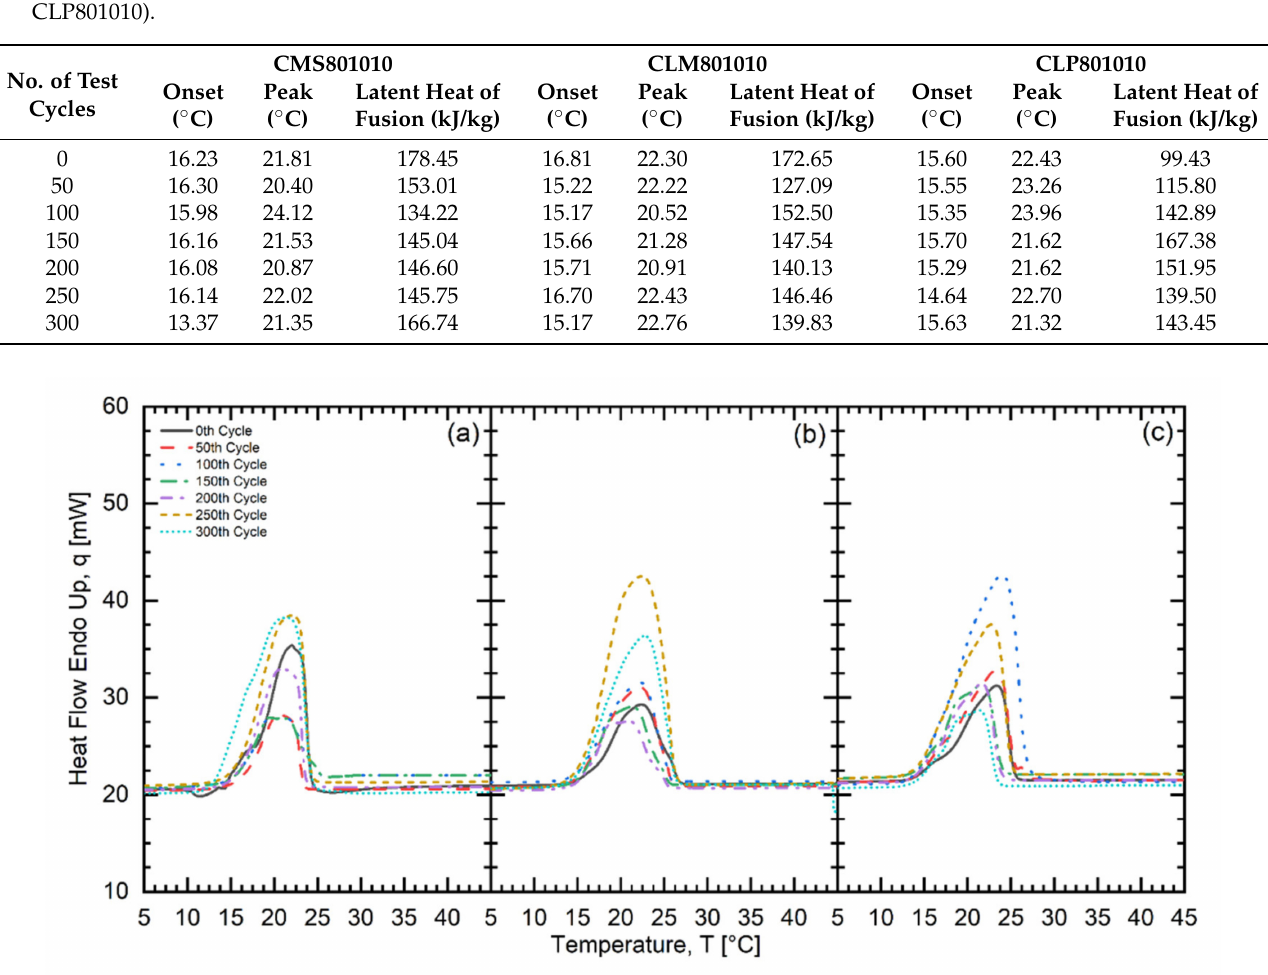
Figure 7. Cycle testing ( a ) CMS801010 ( b ) CLM801010 ( c )